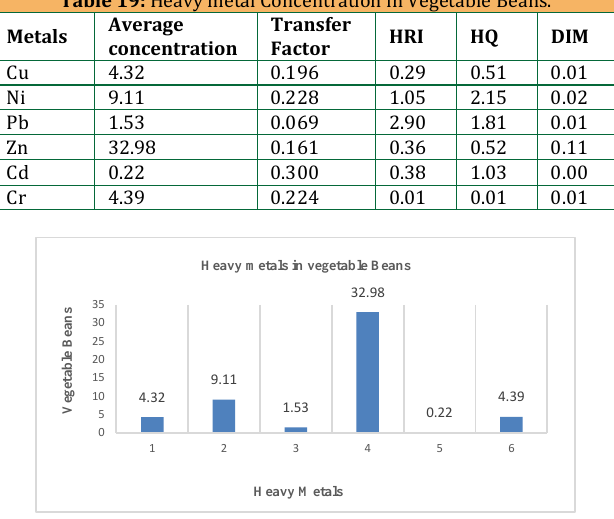
Figure 16: Average Concentration in vegetable Beans